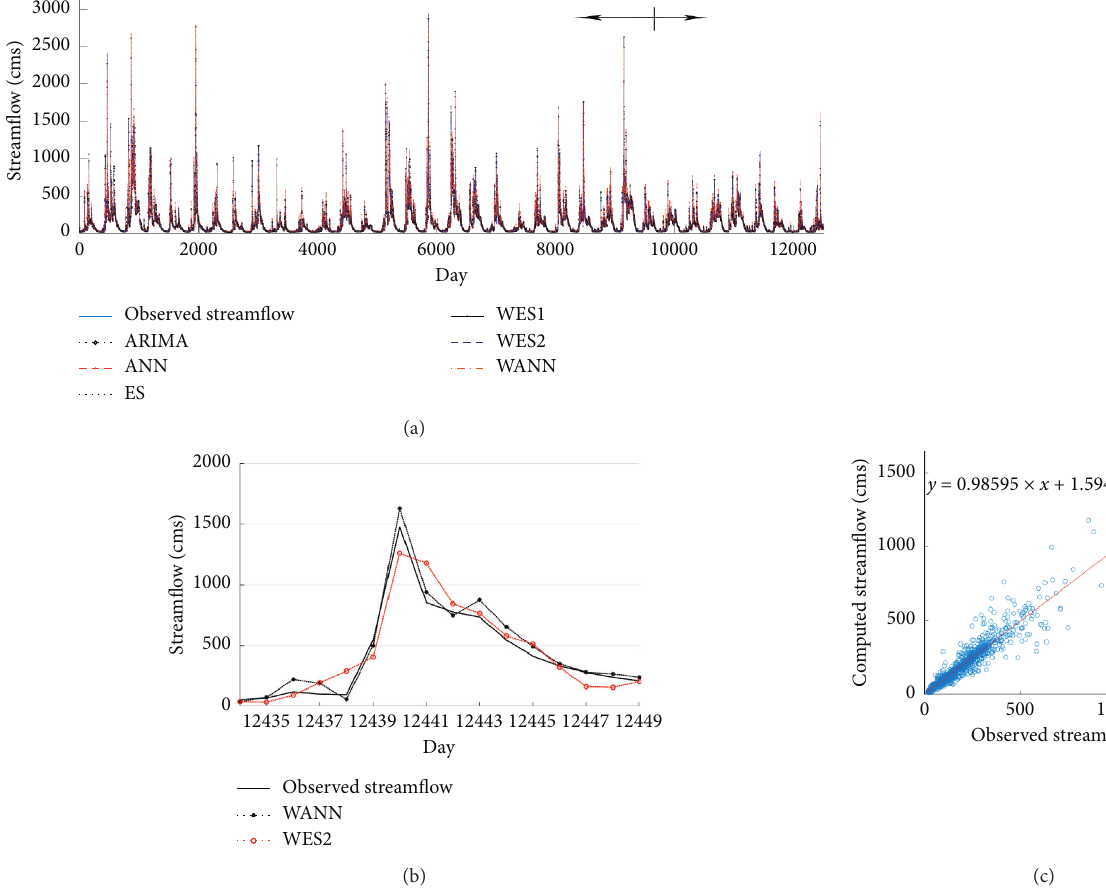
Figure 5: Observed/simulated daily streamflow of Trinity. (a) Whole. (b) Detail. (c) Verification scatter plot of WES